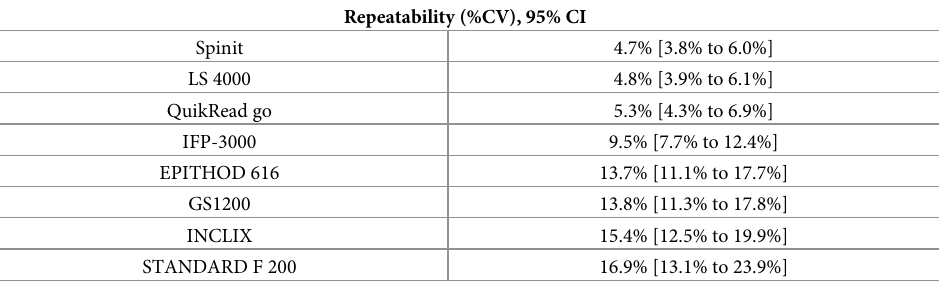
Table 3. Repeatability of quantitative tests.